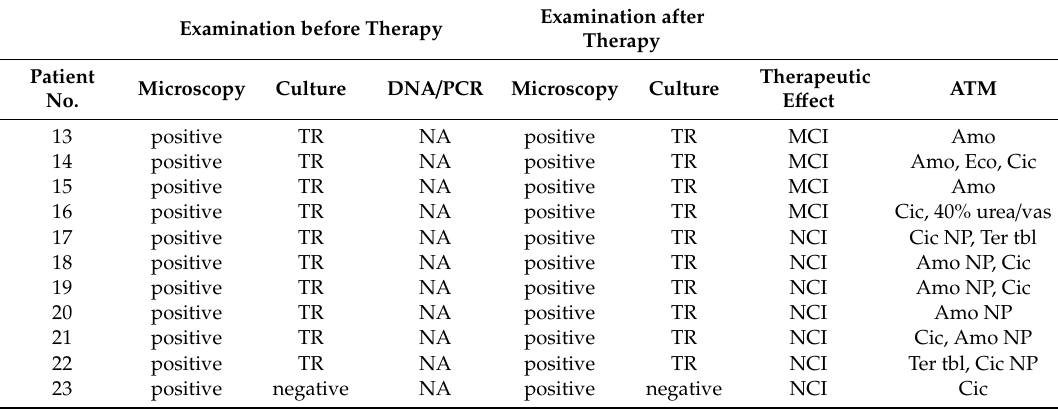
Table 4. Therapeutic e ff ect of ATM combined with NTP, Protocol 2.